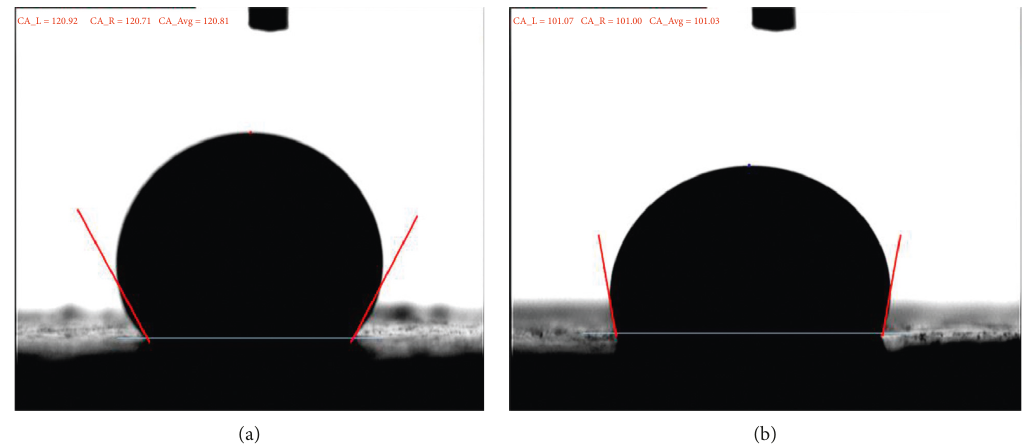
Figure 9: Contact angle. (a) Without adding KH-570 and after adding. (b) 1% KH-570 into resin anchoring agent.